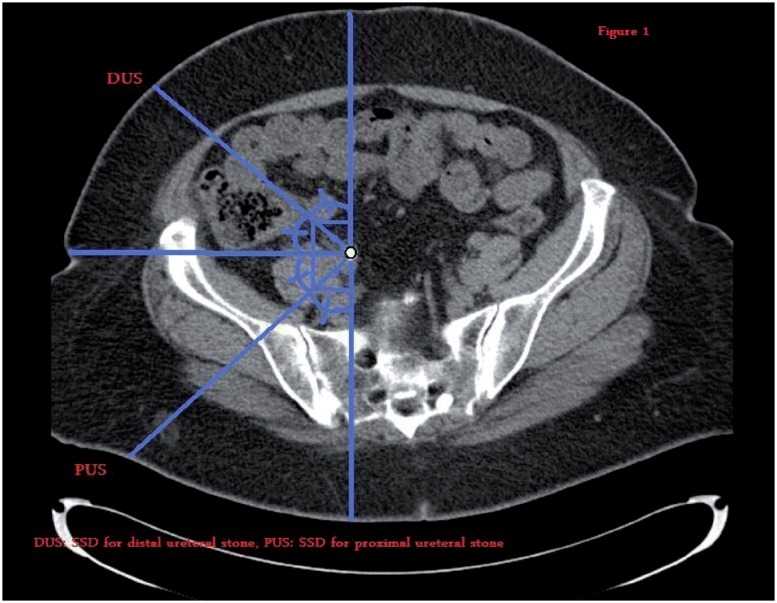
Showing pathways for ultrasonic waves.